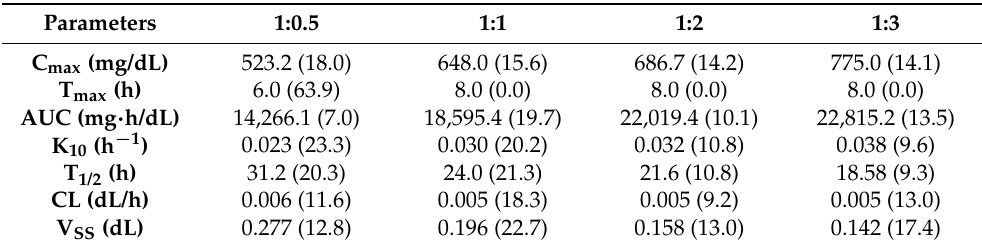
Table 4. Pharmacokinetic parameters (% CV) of phospholipids for micelles containing different ratios of DMPC:DSPE-PEG2k lipid dosed at 136 µ mol/kg.